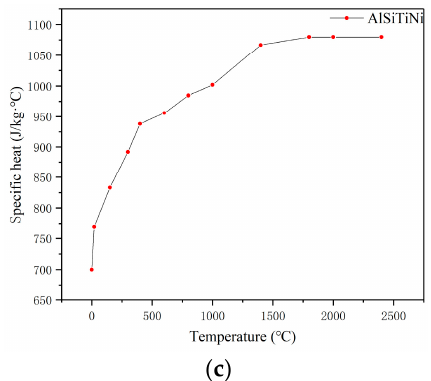
Figure 1. Material properties of the AlSiTiNi in the powder state and in the solid state: ( a ) density; ( b ) thermal conductivity; and ( c ) specific heat.